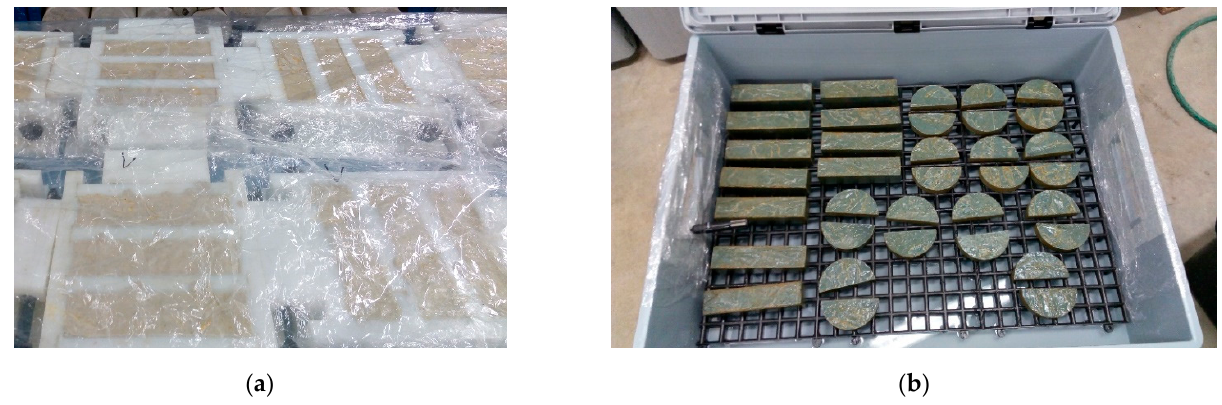
Figure 3. Manufactured test specimens covered with a stretch PE foil ( a ); test specimens after demolding prepared to storage in a closed box with RH > 95% ( b ).